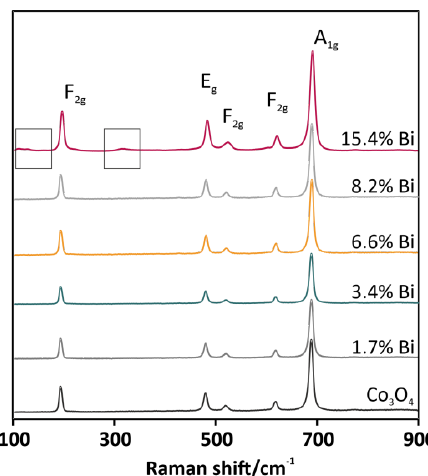
Figure 3. Raman spectra for Co 3 O 4 -based catalysts doped with bismuth in a range of 0–15.4 wt %.